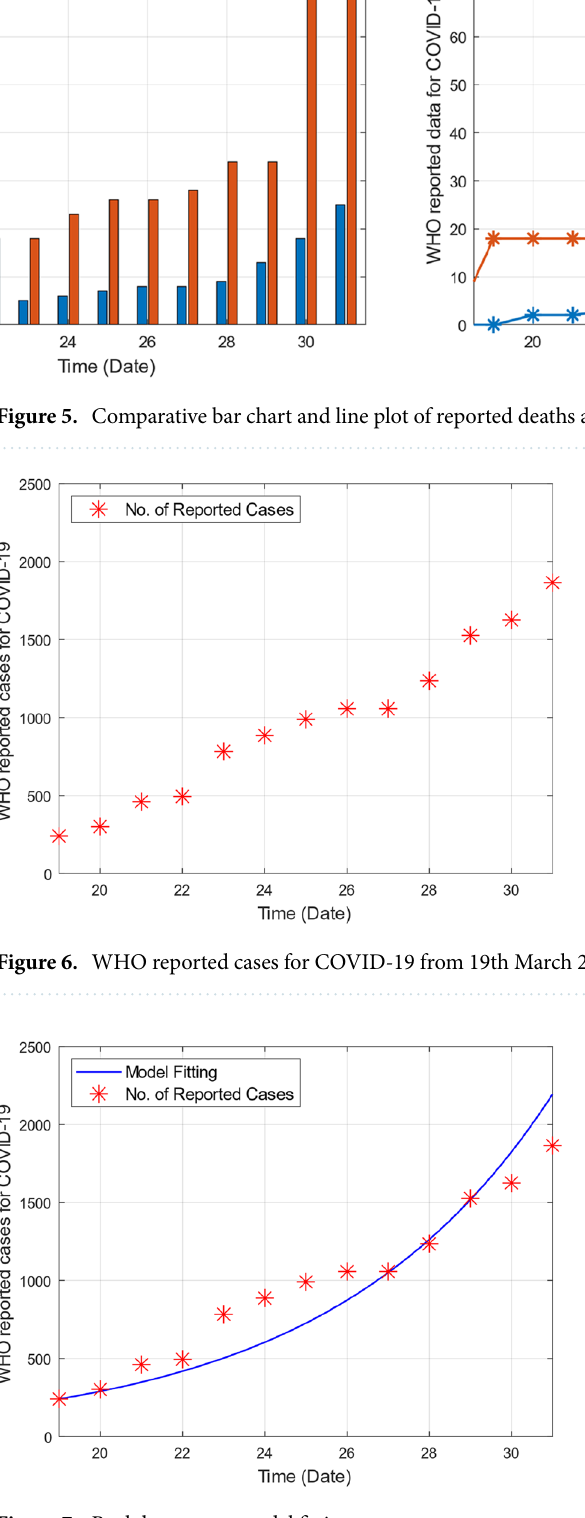
Figure 7. Real data verses model